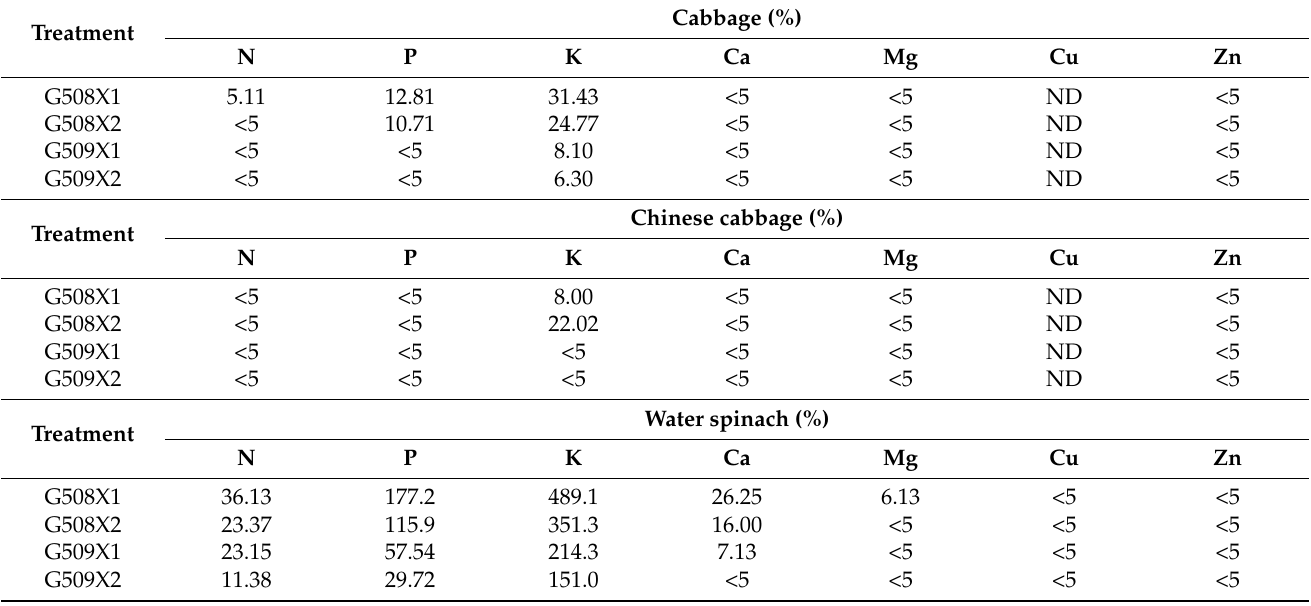
Table 3. Nutrition absorption proportions (NAP) of the three crops under different